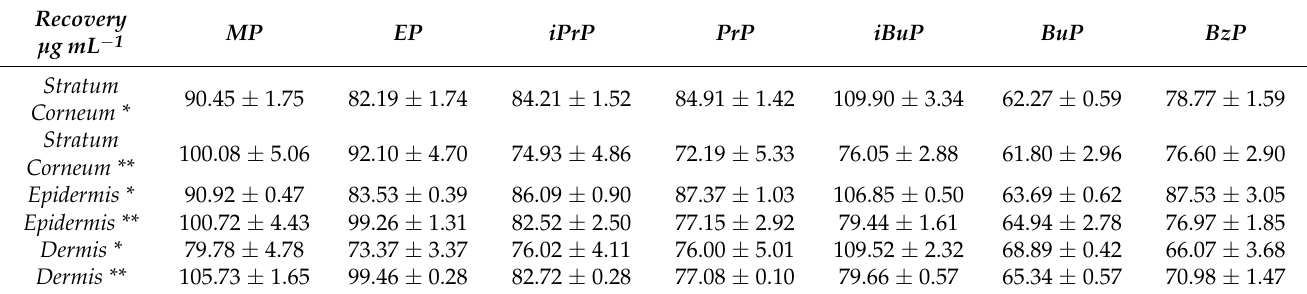
Table 2. Recovery of Parabens (PBs) from each isolated skin layers: Stratum corneum, Epidermis,